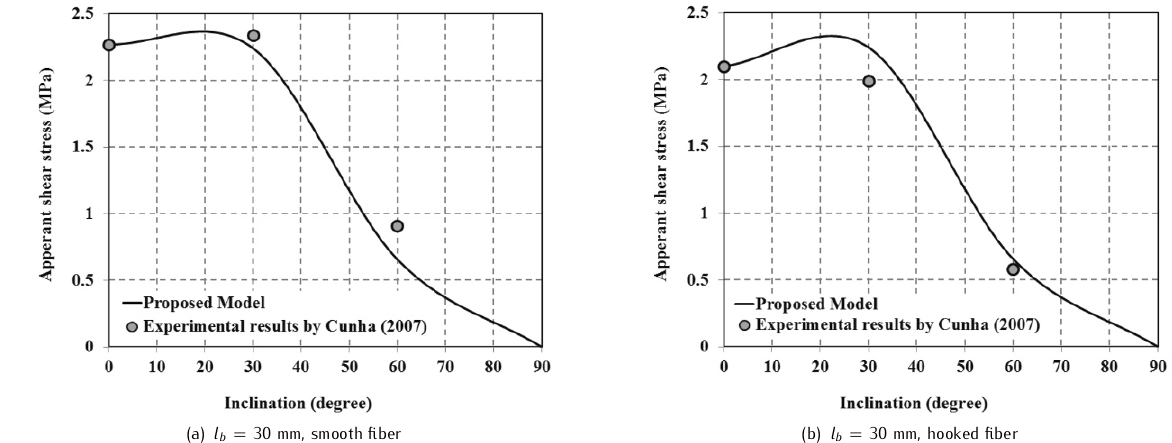
Figure 10. Comparison of the proposed apparent shear strengths (Equation (8)) with shear strengths obtained by using the Cunha [29] experimental results subjected to calibration according to inclination angle by using Equation (2)–(11) in Figure